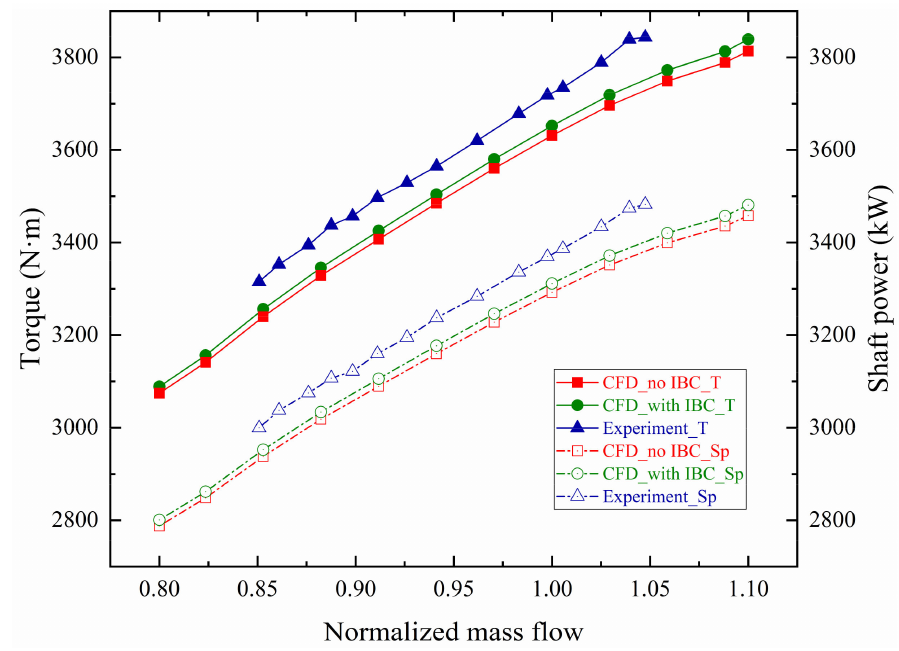
Figure 5. Predicted and measured power consumption under design rotating